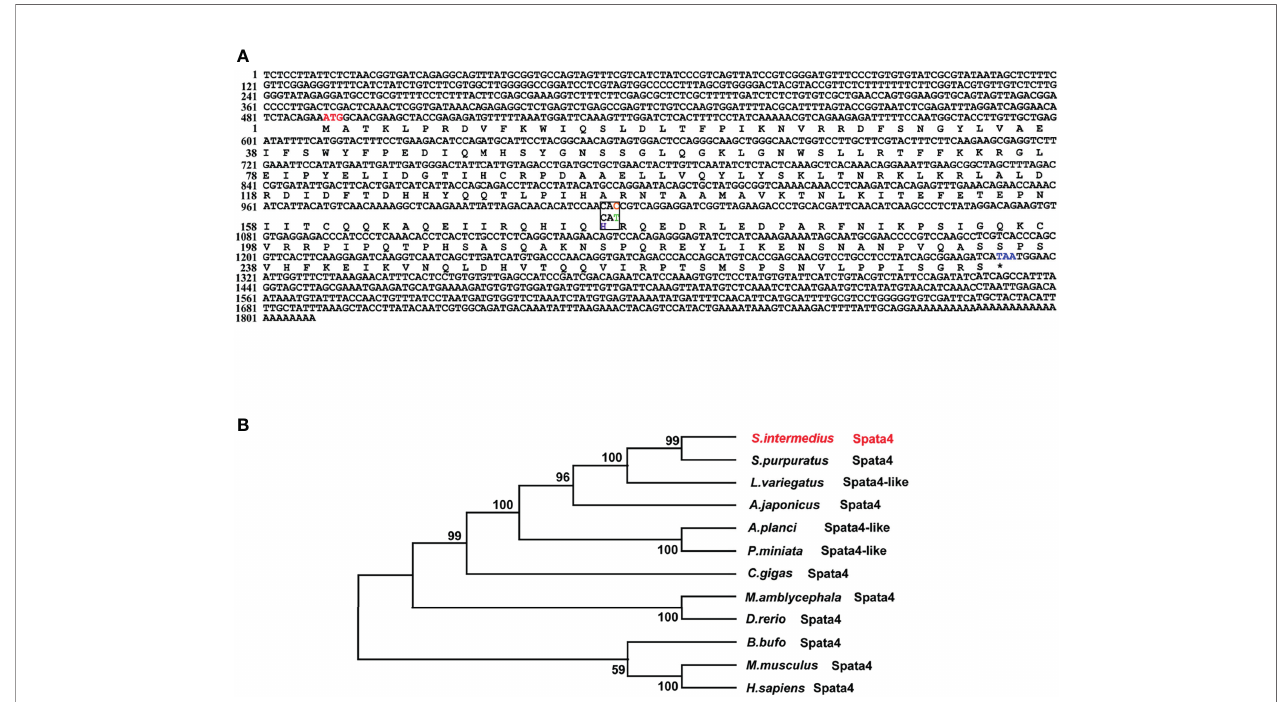
FIGURE 2 | Sequence analysis of spata4 in S. intermedius . (A) Coding sequence and deduced amino acid sequences of spata4 in S. intermedius. (B) Phylogenetic tree of Spata4